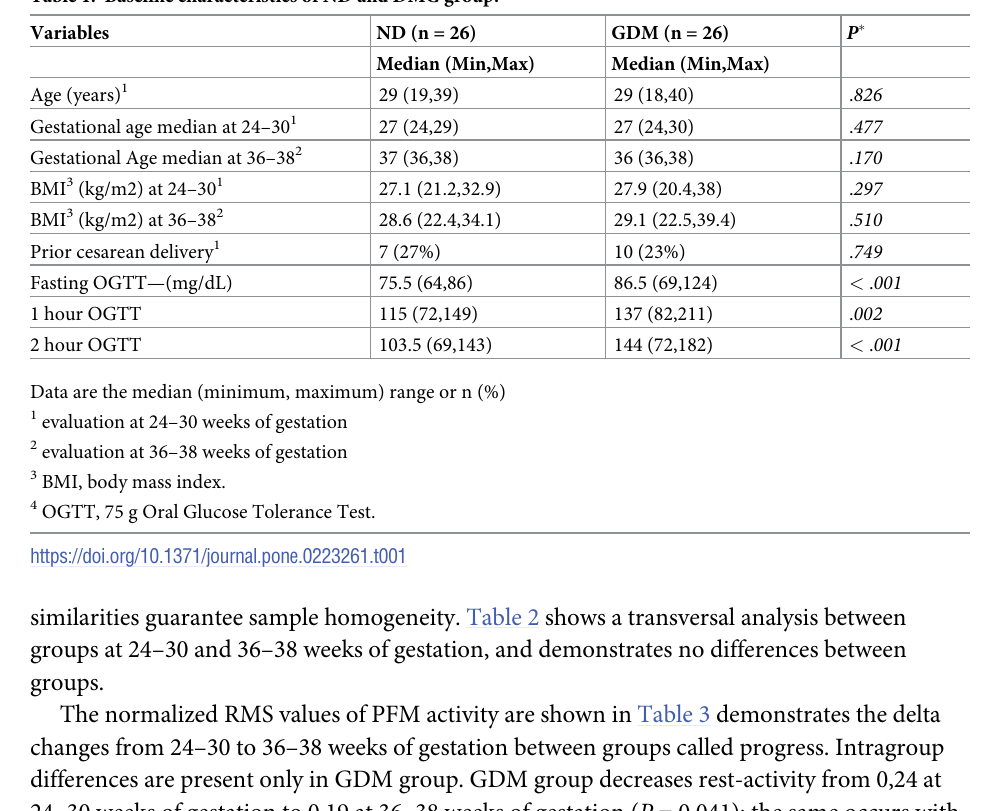
Table 2. Comparison between normalized root mean square (RMS) values from electromyography activity of pel- vic floor muscles (PFM) in rest, fast contraction, and hold contraction from non-diabetic (ND) and gestational diabetes mellitus (GDM) groups at 24–30 and 36–38 weeks of gestation. Variables